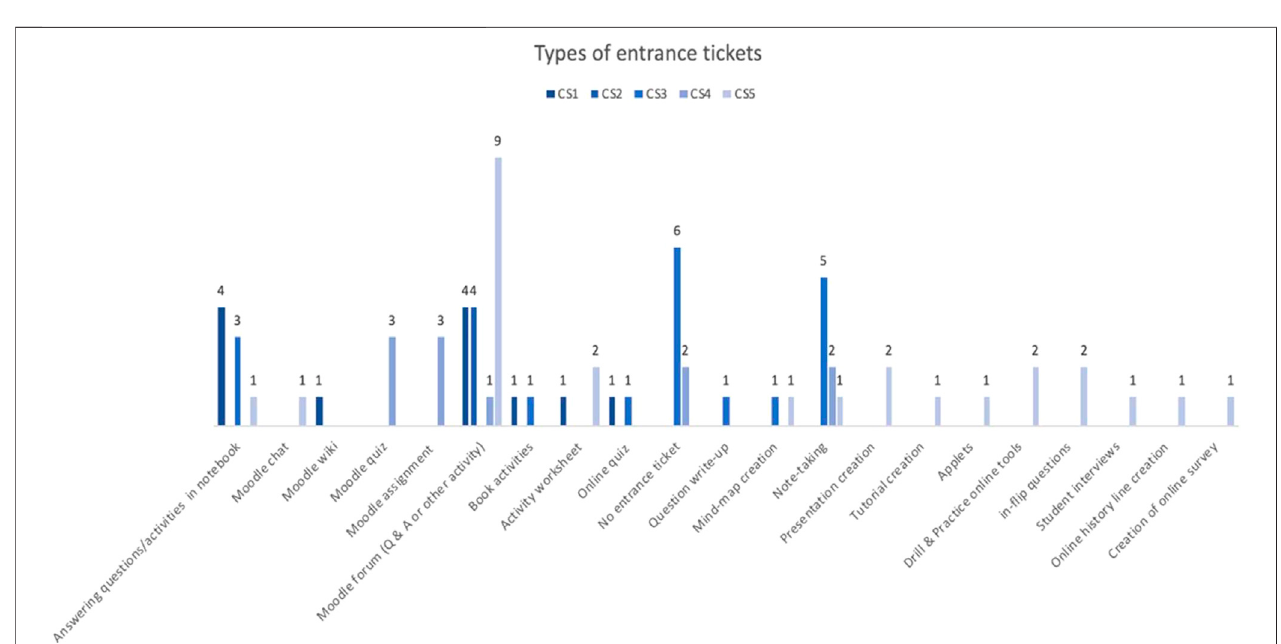
FIGURE 2 | Types of entrance tickets used in all case